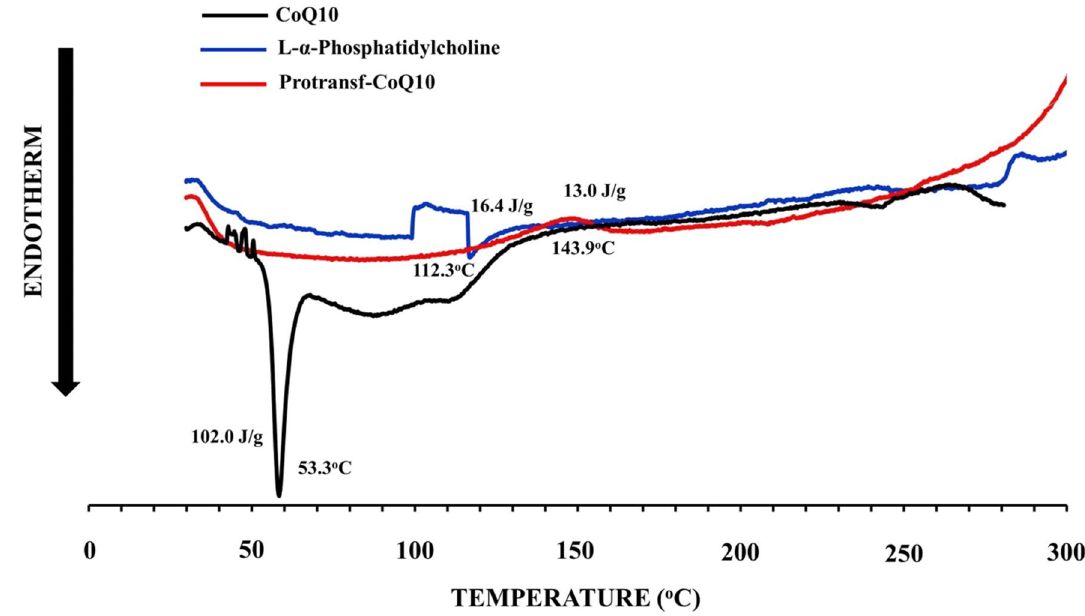
Figure 4. Differential thermal analysis of Coenzyme Q10 (CoQ10), L-α-Phosphatidylcholine as phospholipid component of protransfersome, and protransfersome loaded CoQ10 (Protransf-CoQ10).